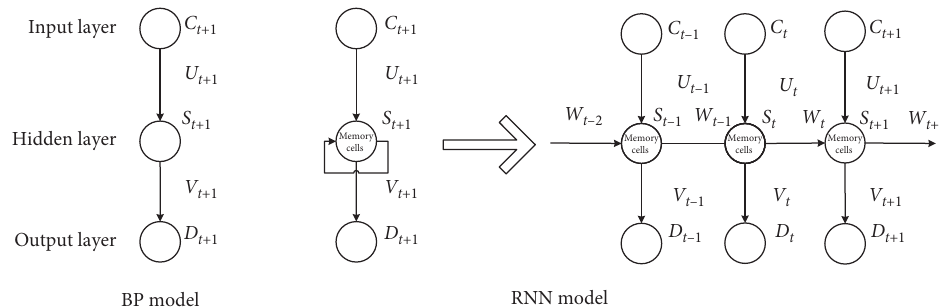
Figure 3: Static and dynamic model